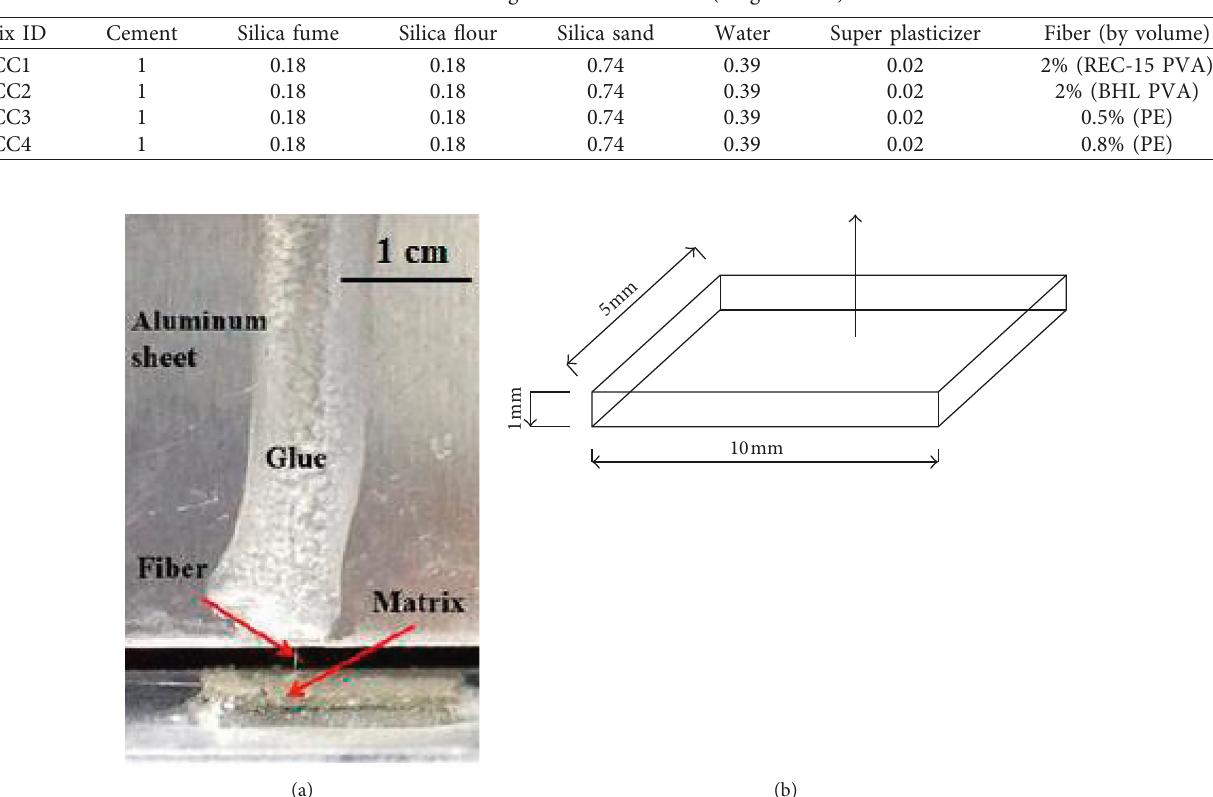
Figure 2: Single fiber pullout test setup: (a) the tested specimens; (b) the dimension of specimens (all dimensions in